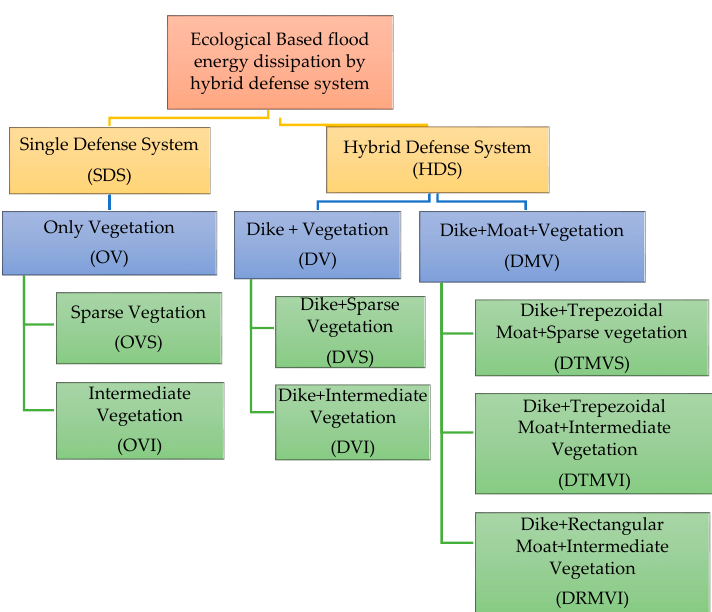
Figure 2. Experimental setup: ( a ) Schematic of the channel with models, ( b ) experimental setup of the hybrid defense system in the laboratory, ( c ) vegetation arrangement details of staggered strips (SS).